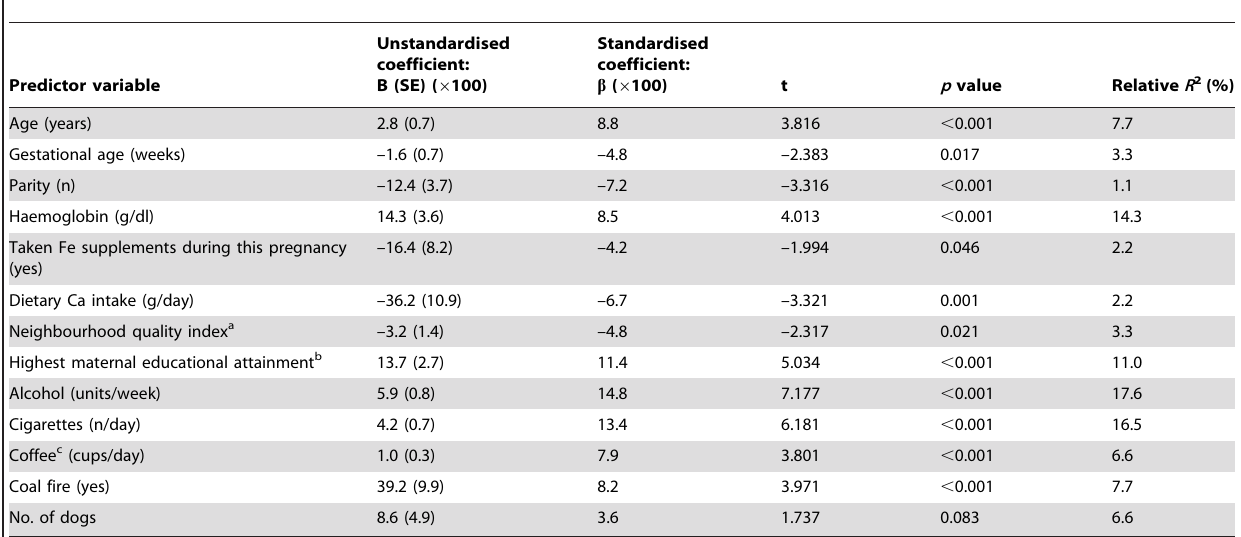
Table 2. Regression coefficients for variables that remained after backward stepwise elimination procedures in a multiple linear regression model predicting maternal BLL.